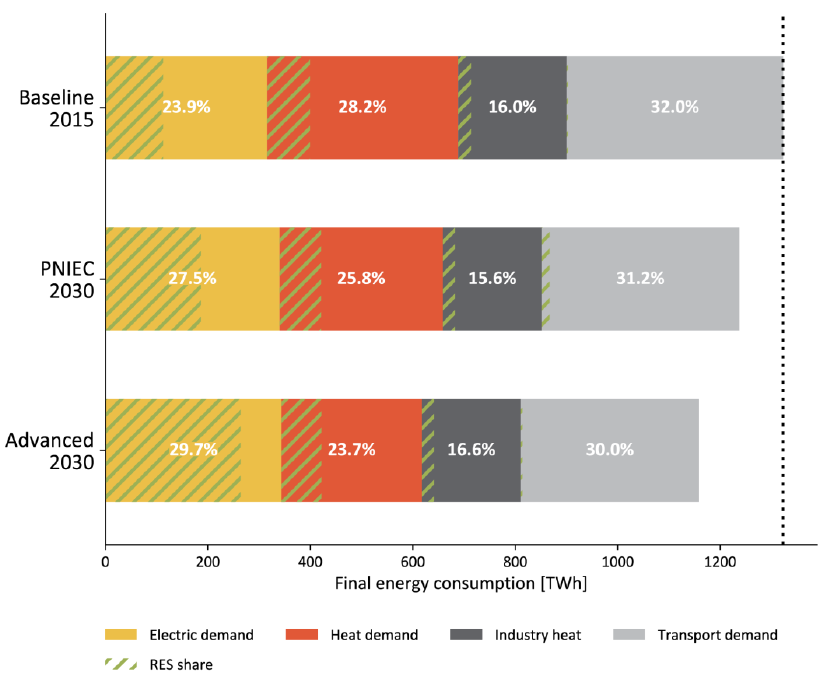
Figure 11. Annual energy consumption in electricity, heat, industry and transport sectors for the scenarios Baseline 2015, PNIEC 2030 and Advanced 2030.